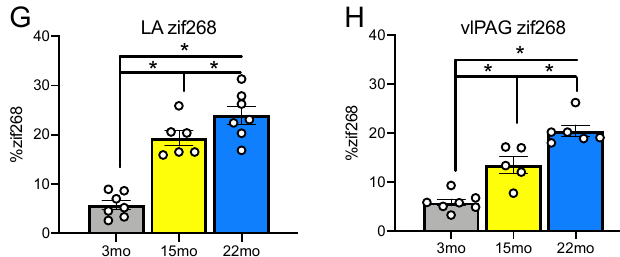
Figure 1. Behavioral results from the retrieval test in a neutral context (mean and SEM) are shown in Panel ( A ). Panels ( B – H ) show zif268 expression reported as a percentage (mean and SEM) of total DAPI present in the same section. Zif268 was increased in both 15-month-old and 22-month-old animals relative to 3-month-old animals in the medial prefrontal cortex (mPFC) ( B ), the aRSC ( C ), pRSC ( D ), dorsal hippocampus (DH) ( E ), ventral hippocampus (VH) ( F ), LA ( G ), and ventrolateral periaqueductal gray (vlPAG) ( H ). In the pRSC, VH, LA, and vlPAG, 22-month-old animals also showed increased zif268 relative to 15-month-old animals. Asterisks indicate p < 0.05; pound signs indicate p < 0.10. White dots represent individual rats.